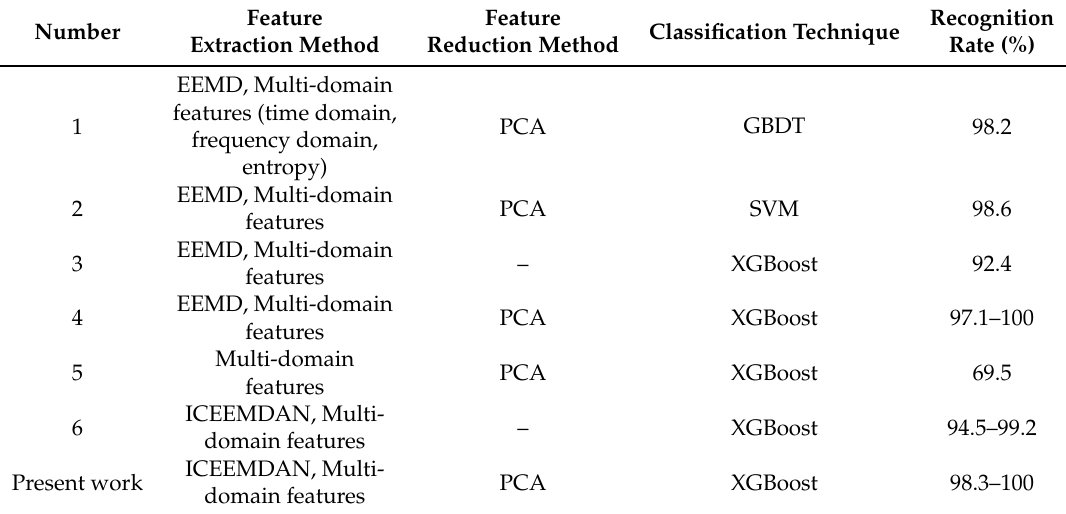
Table 6. Performance comparison for different